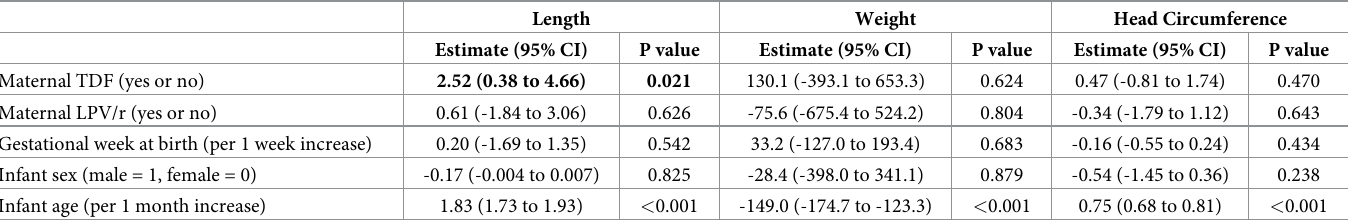
Table 3. Results of multivariate regression analysis of the association of various maternal/infant factors with infant body length, weight, and head circumference.